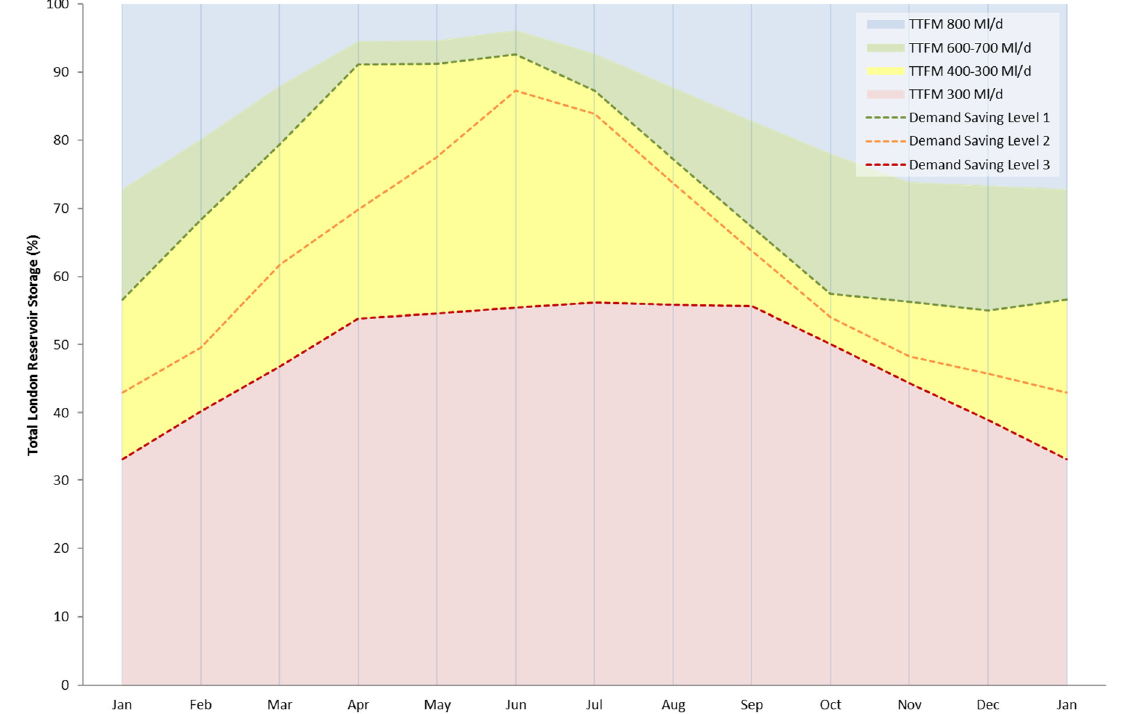
/ day. Water 2020 , 12 , x FOR PEER REVIEW